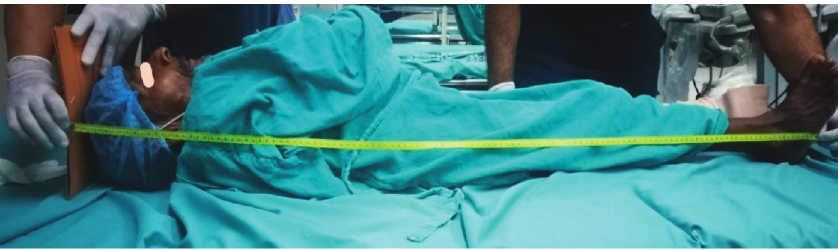
Figure 3: Short stature of the patient.